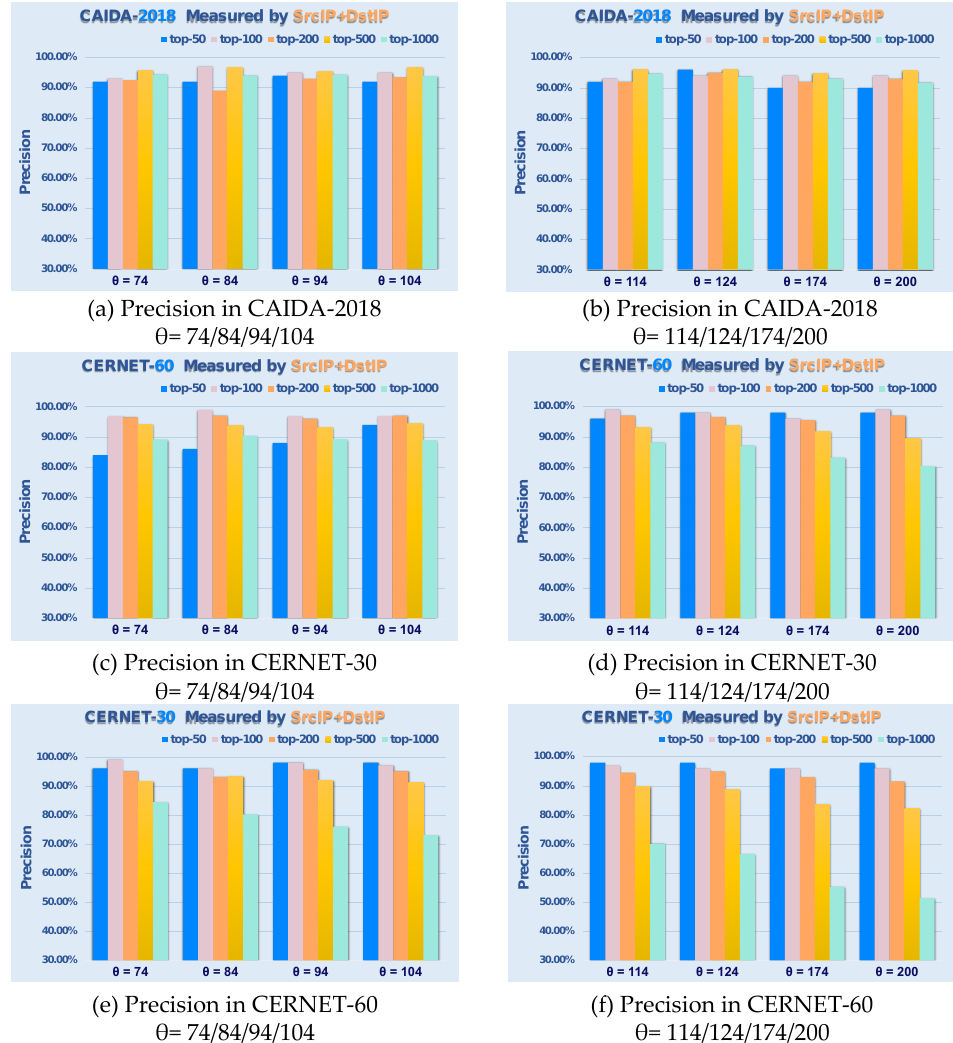
Figure 9. Experiments on precision vs . SrcIP/DstIP. ( a ) Precision in CAIDA-2018. ( b ) Precision in CAIDA-2018. ( c ) Precision in CERNET-30. ( d ) Precision in CERNET-30. ( e ) Precision in CERNET-60. ( f ) Precision in